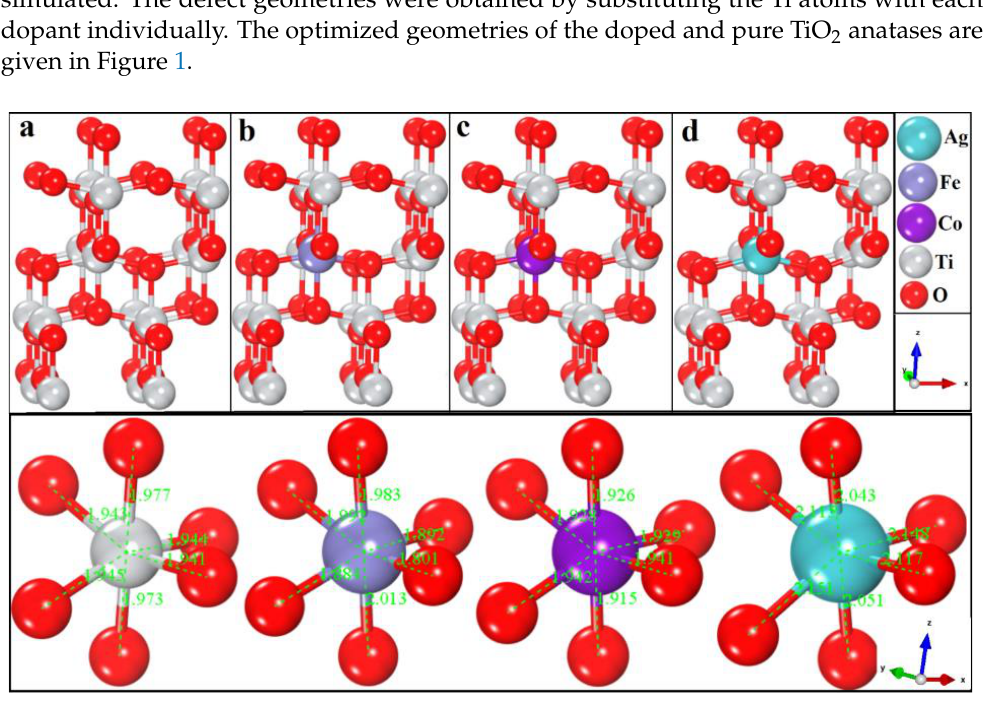
Figure 1. Relaxed geometries of ( a ) TiO 2 , ( b ) TiO 2 /Fe, ( c ) TiO 2 /Co, and ( d ) TiO 2 /Ag.